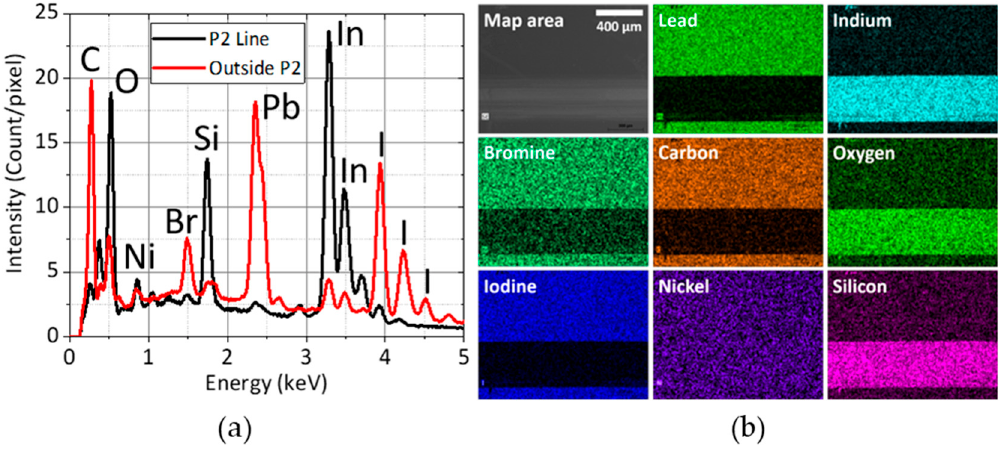
Figure 3. ( a ) Average EDX spectra over the P2 line and the area outside it; ( b ) A matrix of SEM image and EDX elemental maps. The P2 is located on the bottom side of each map.